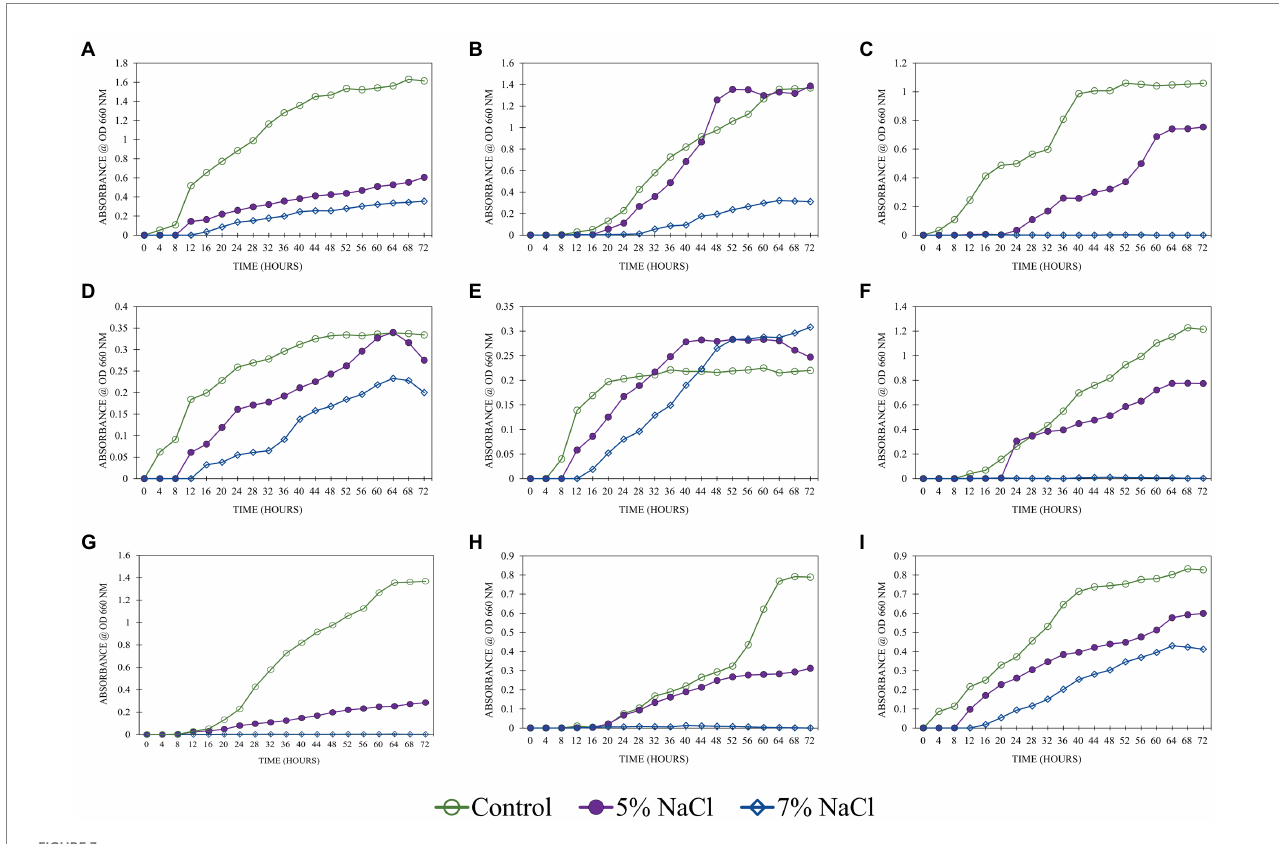
FIGURE 3 Salinity tolerance of the bacterial isolates under different levels of NaCl (0% -control, 5%, 7%) A: SPP 2 - M. indicus , B: SPP 5 - N. niacini , C: SPP 6 - S. warneri , D: SPTT 3 - B. velezensis , E: SPTT 7 - B. circulans , F: SPTT 8 - K. rhizophila , G: SPTV 3 - B. oleronius , H: SPTVE 3 - S. marcescens and I: SPTVE 4 - K. radicincitans